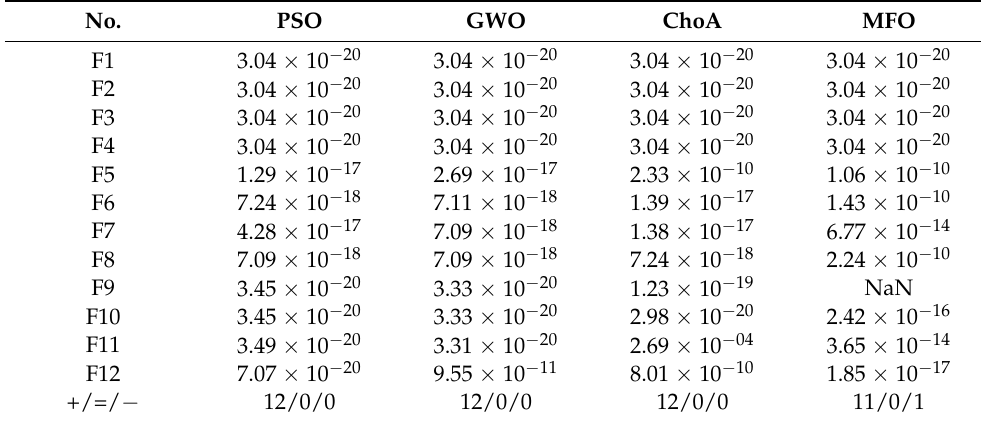
Table 4. Wilcoxon rank-sum test